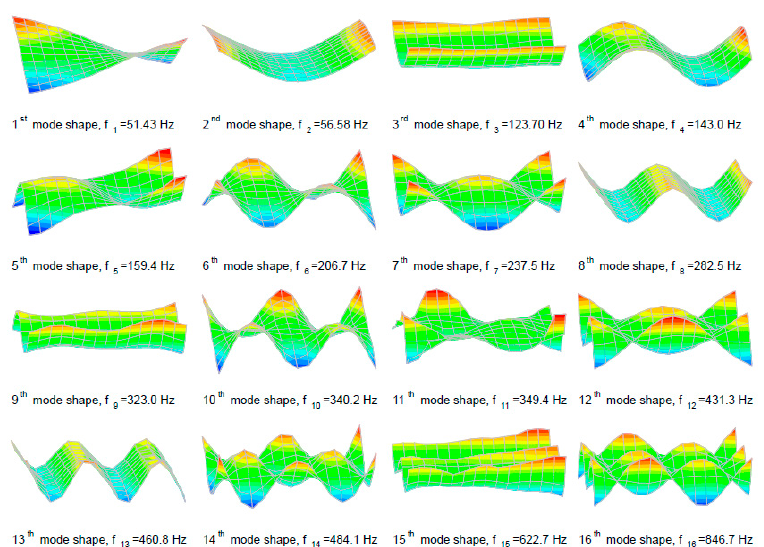
Figure 3. Sixteen mode shapes obtained experimentally on the undamaged plate.